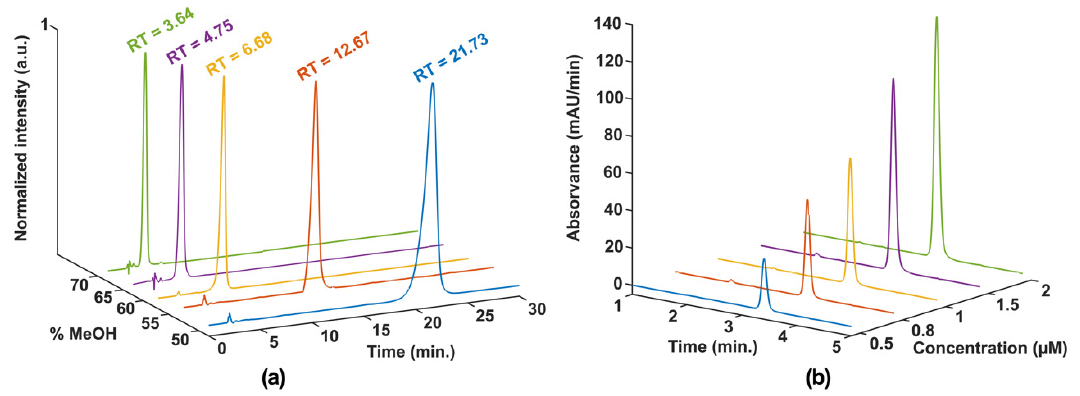
Figure 6. Chromatograms of XD-10. ( a ): RP-HPLC method on the C18 column with different proportions of MeOH in the mobile phase, a flow rate of 1.0 mL/min, and detection at 254 nm; ( b ): VALLME method coupled to HPLC, with different XD-10 concentrations present in the n -octanol phase (chromatographic conditions: water/MeOH (70:30 v/v ) as mobile phase, the flow rate of 1.0 mL/min, and detection at 254 nm). (Reprint with permission from [225], Copyright (2018) ELSEVIER).